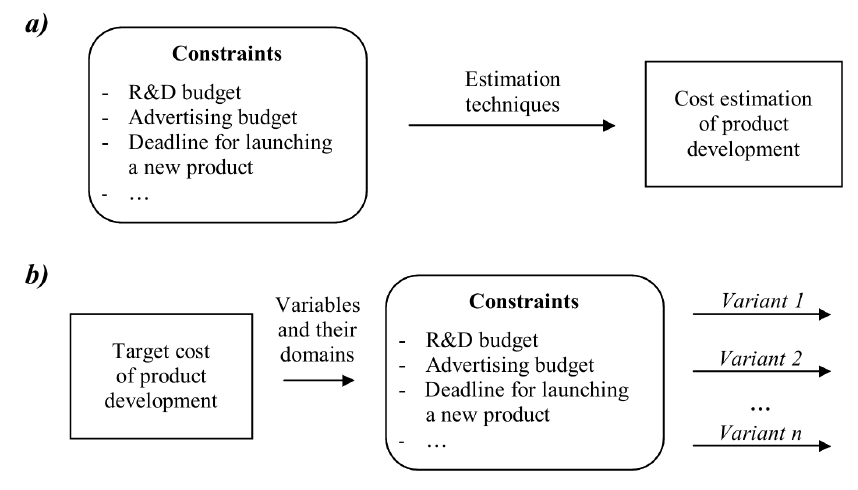
Figure 2. The project prototyping problem stated in a forward ( a ) and inverse form ( b ).